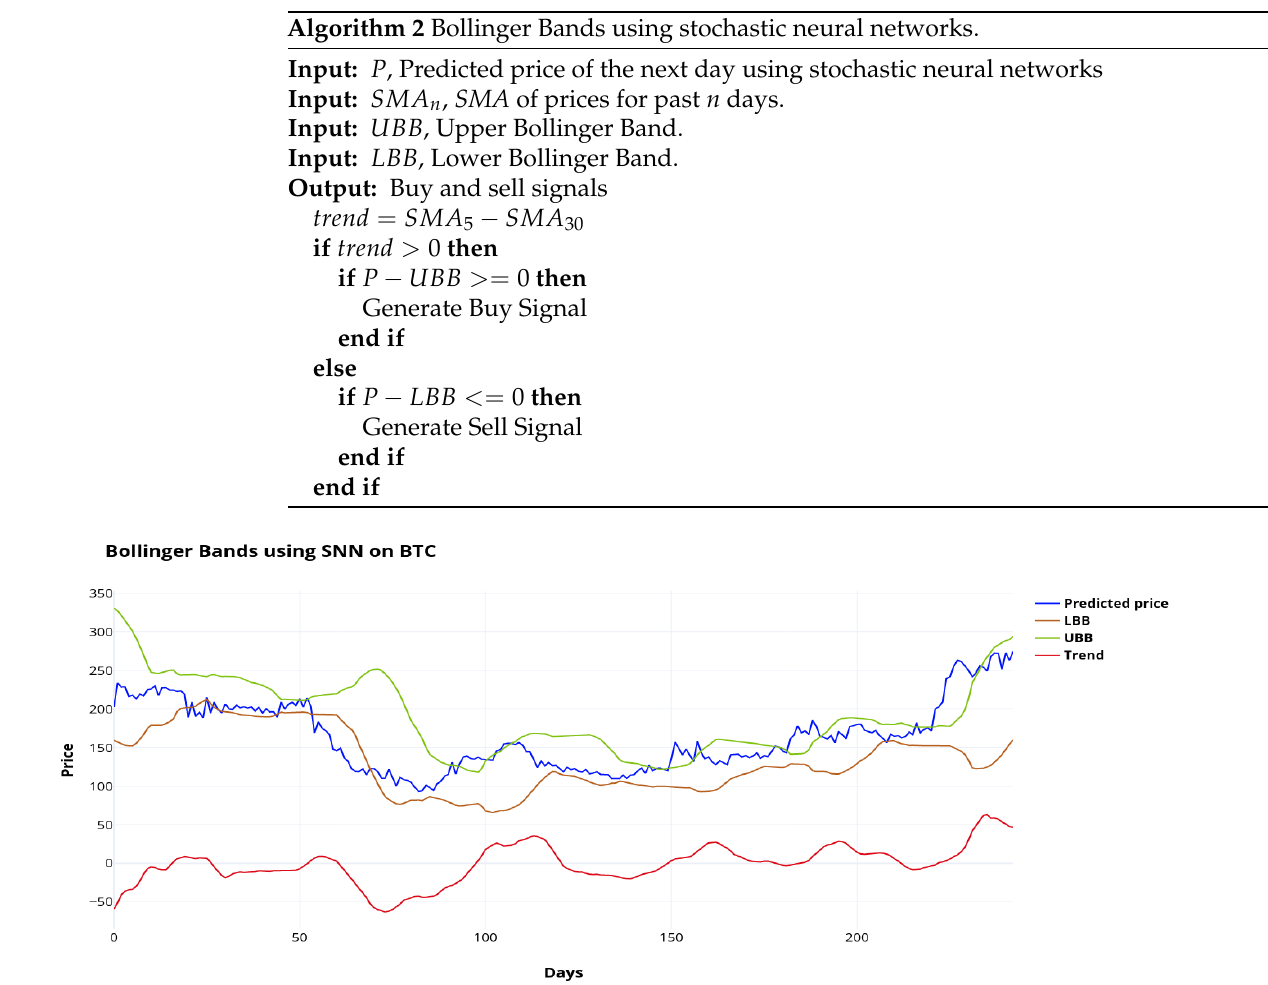
Figure 4. Bollinger Bands strategy using SNN on